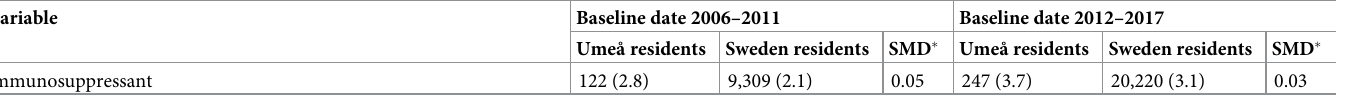
Standardized mean difference. a Education and civil status recorded in the calendar year before the baseline date.